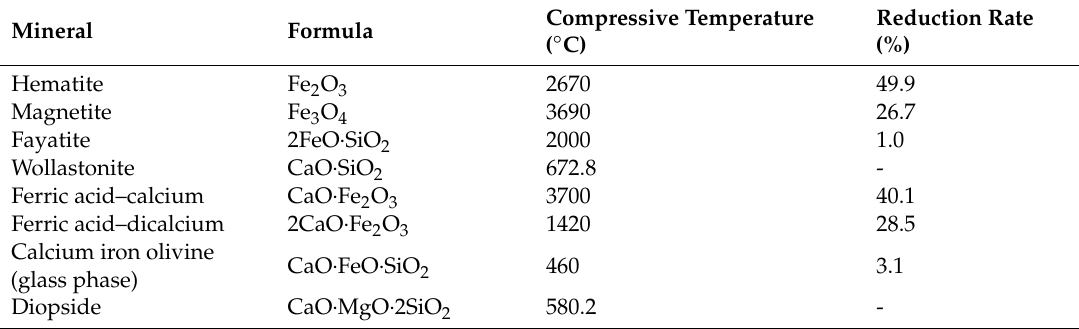
Table 7. Compressive strength and reduction of main components of sinter ore